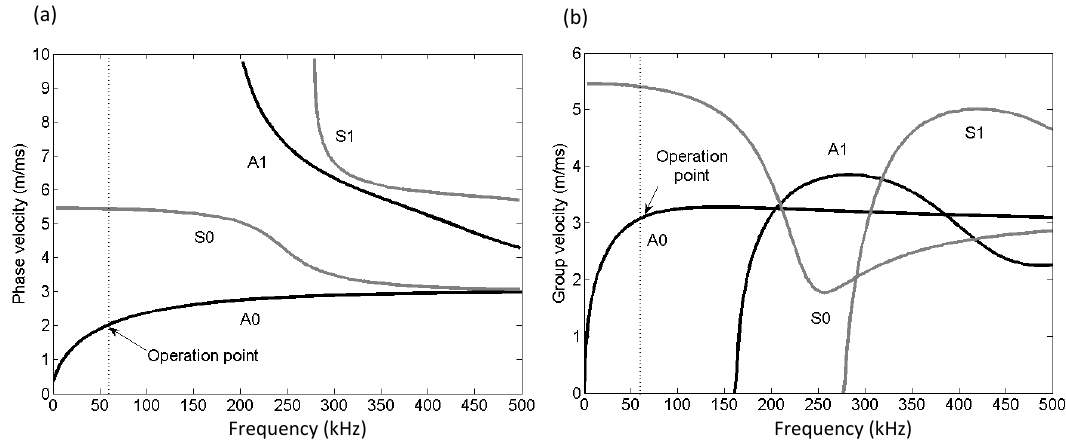
Figure 2. Dispersion curves of Lamb waves in a 10 mm thick steel plate. ( a ) Phase velocity and ( b ) group